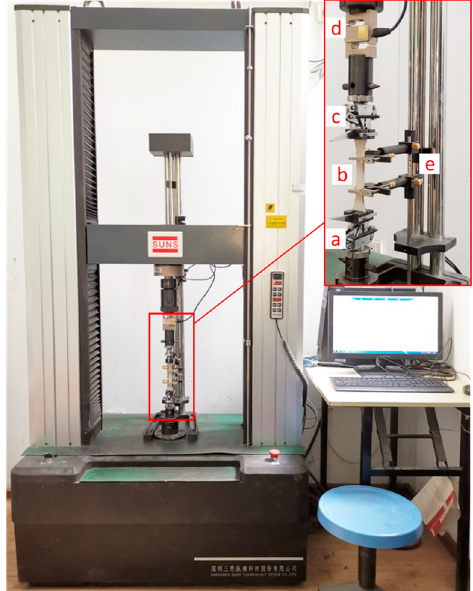
Figure 7. Test setup. ( a ) lower grip, ( b ) specimen, ( c ) upper grip, ( d ) load cell, ( e ) extensometer.